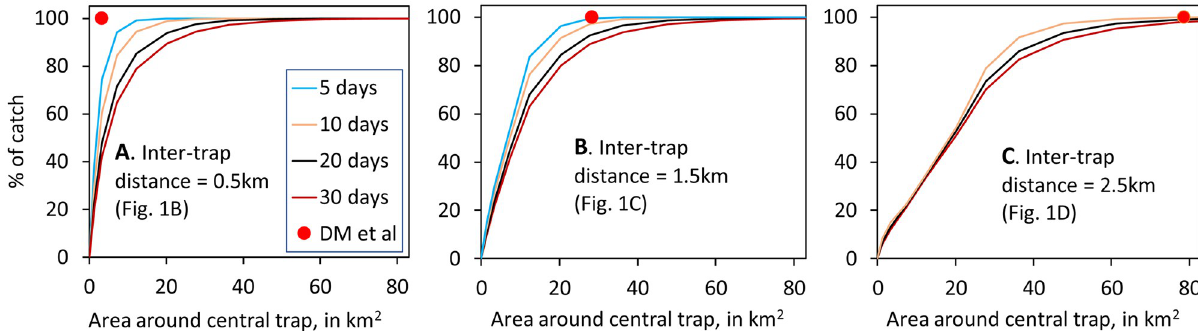
Fig 6. Percentage of the total catch of five traps that was regarded as originating from various circular areas around the central trap, when the other traps in the group were at various distances from the central trap, as shown in the maps of Fig 1B–1D. The inter-trap distance shown on each of the charts (A-C) of the present figure is the distance between a trap and its closest neighbour. The red plot on each chart indicates the estimated area needed to account for 100% of the catch after any number of days, as calculated by the method of De Meeuˆs et al. [1]. In chart C, the sampled area for five days of trapping is not shown since the separation between adjacent traps (inter-trap distance) is greater than the maximum possible distance that the flies could have moved in that time, i . e ., there was no substantial overlap in the situations sampled by adjacent traps. Without such overlap, the notion of a pooled area of sampling is an excessive abstraction.